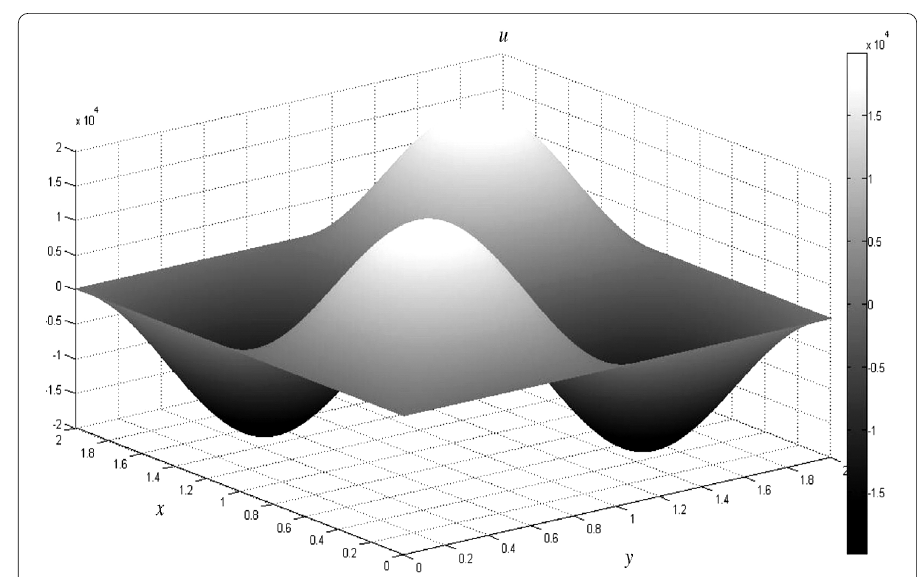
Figure 2 CNFVE solution with the second-order accuracy when t = 2